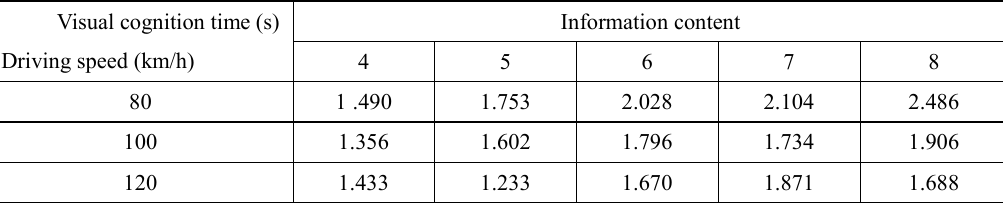
Table 2 Fixation duration on different information content with changed speeds